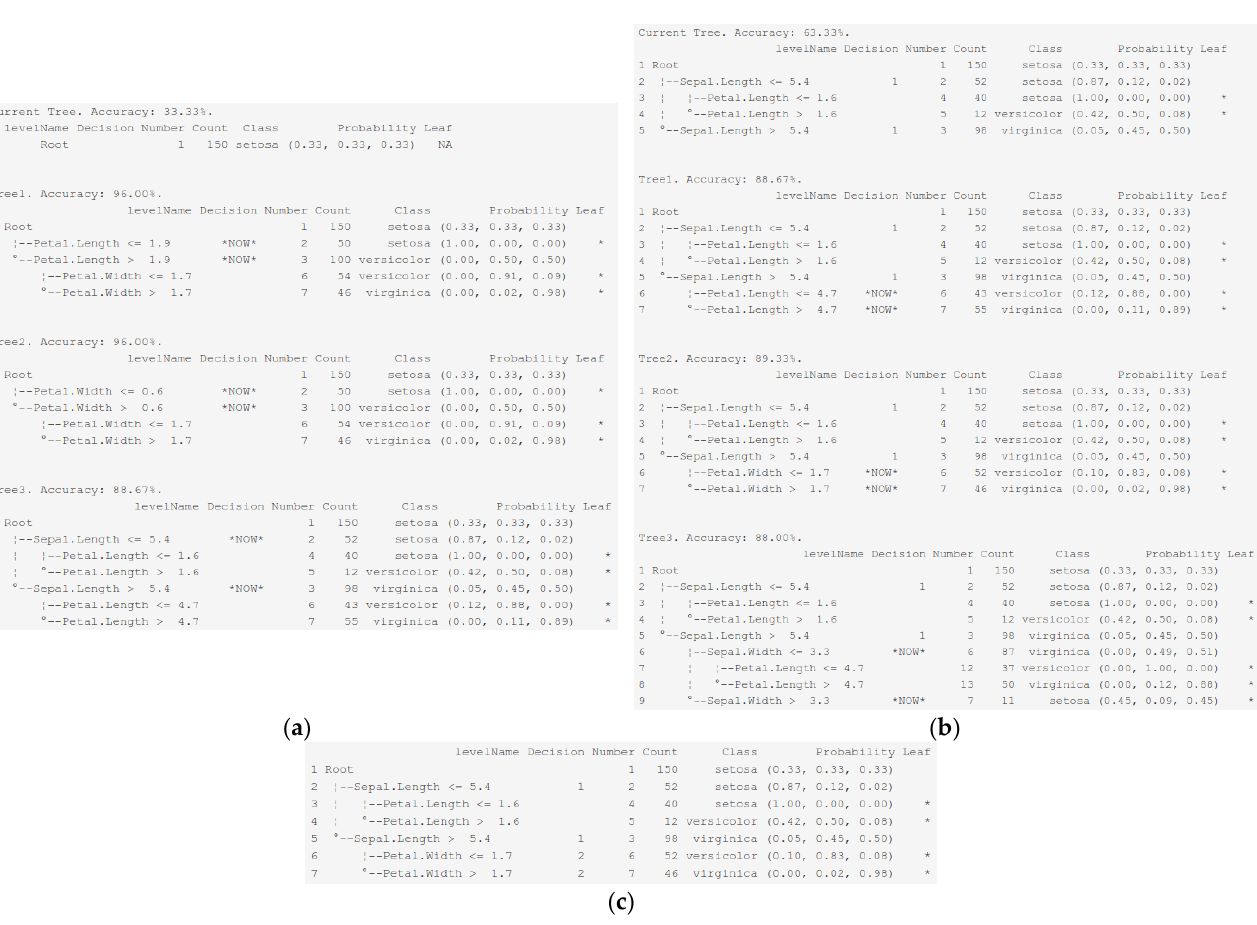
Figure 6. ( a – c ) Exemplary steps for interactive tree learning using the second type of ambiguity for the Iris data set.